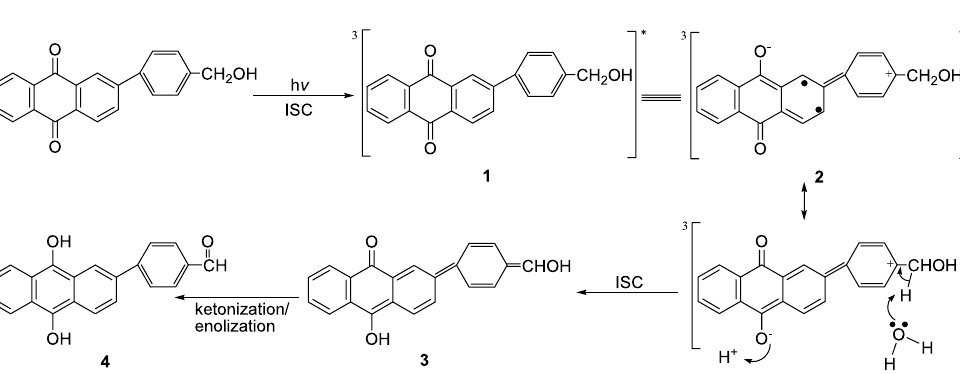
Figure 1. Optimized chemical structures of the triplet state of ( a ) HEAQ and ( b ) PPAQ obtained from B3LYP/6-311 G ** DFT calculations.